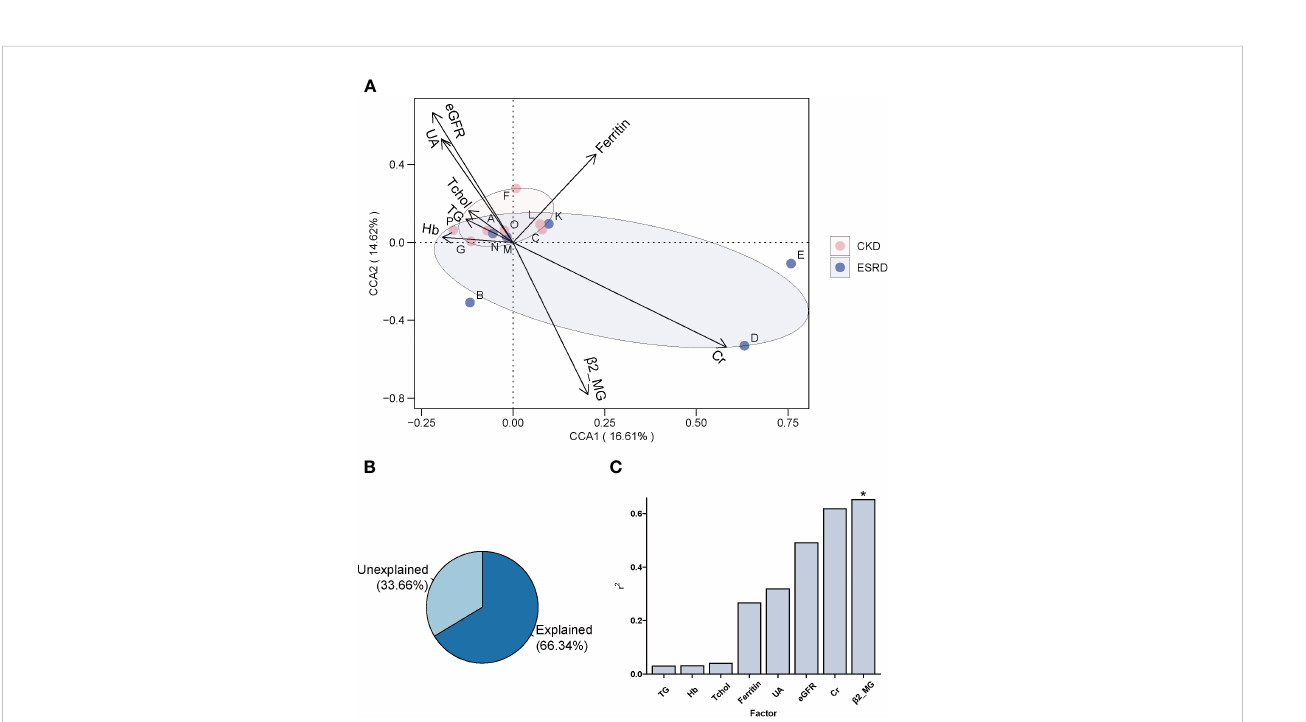
FIGURE 4 The association between clinical indicators and genera composition. (A) Clinical indicators explanation for changes in the gut microbiota of patients by CCA analysis. (B) The amount of variation in community structure explained by pathogenetic factors. (C) Histogram of the amount of variation in community structure explained by each pathogenetic factor. (env fi t analyze, * P -value <